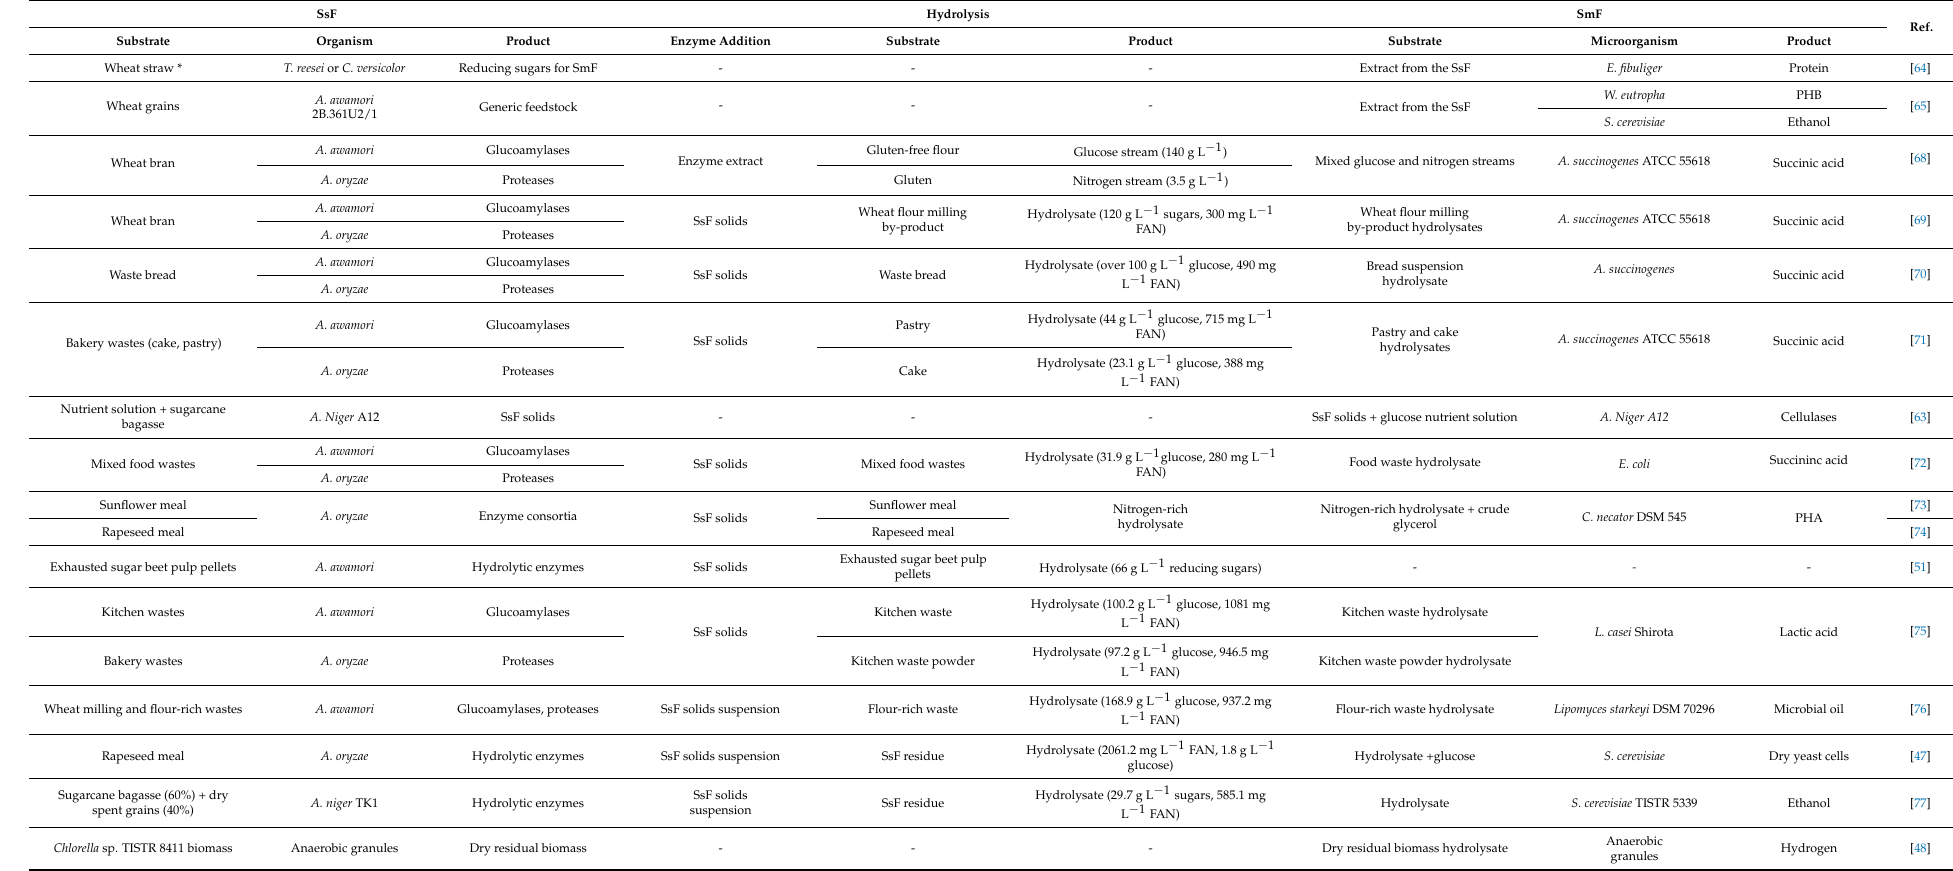
Table 2. Studies carried out performing sequential solid and submerged